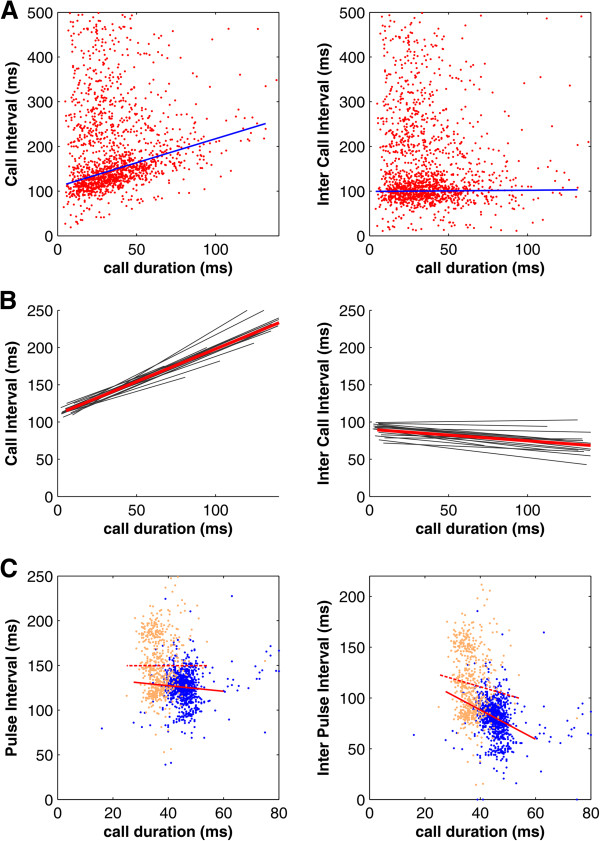
Relationships between call parameters. (A) Relationships between call parameters in an example mouse showing a significant correlation between CD and CI and no correlation between CD and ICI. (B) Regression lines for the relationships of call parameters for all mice showing a significant stronger correlation between CDs and CI that between CD and ICI. Red lines indicate the mean regression lines (C) Relationships between call parameters in two horseshoe bats (a different color is used for each bat individually) indicating no correlation between CD and CI, but a significant negative correlation between CD and ICI. Dashed and solid lines indicate regression lines for the relationships between call parameters of bat #1 and #2, respectively.